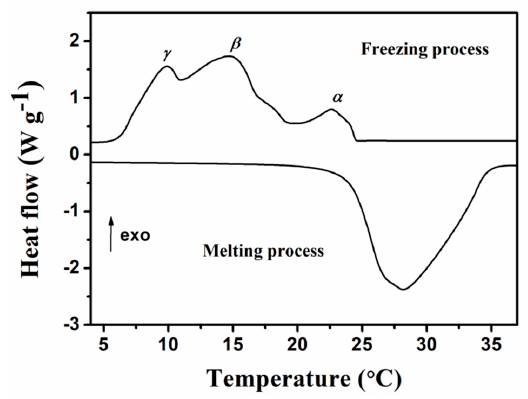
Figure 7. DSC curve of MicroPCMs. Table 1. Phase change properties of the MicroPCMs/epoxy